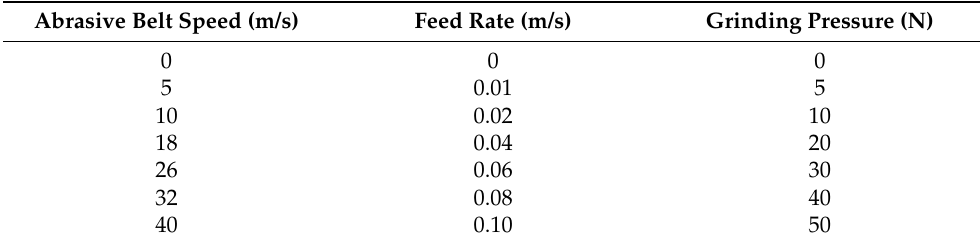
Table 3. Processing parameter selection table in the exploratory experiment.